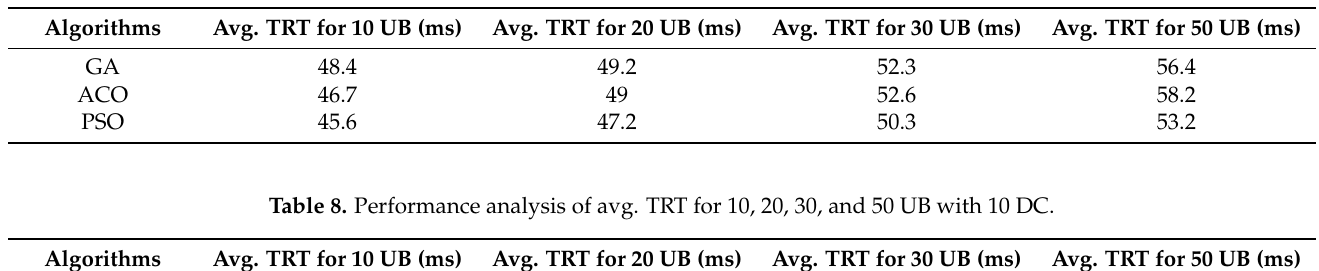
Table 7. Performance analysis of avg. TRT for 10, 20, 30, and 50 UB with 5 DC.